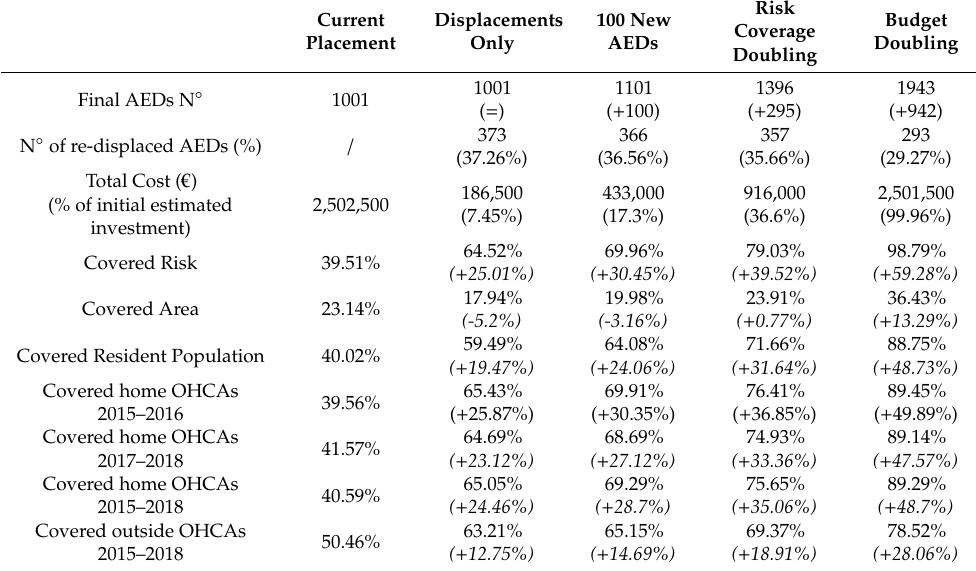
Table 3. Detailed results of performance analysis of the simulated scenarios for new distributions of Automated External Defibrillators (AEDs); signed values within brackets represent the delta in respect to the corresponding value in the current placement (first